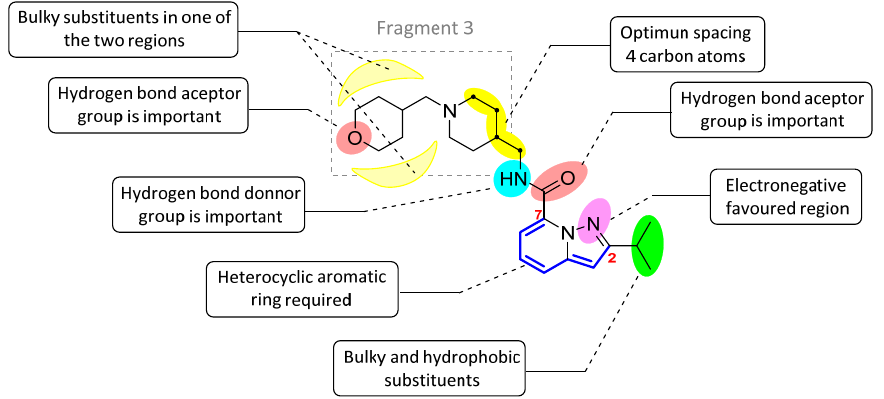
Figure 9. Main structure-activity relationships derived from this study.